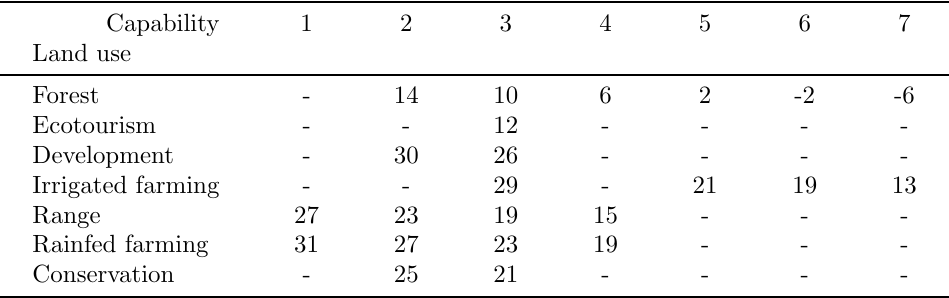
Table 4: Sum of scores for different land uses based on capability classes and 4 scenarios